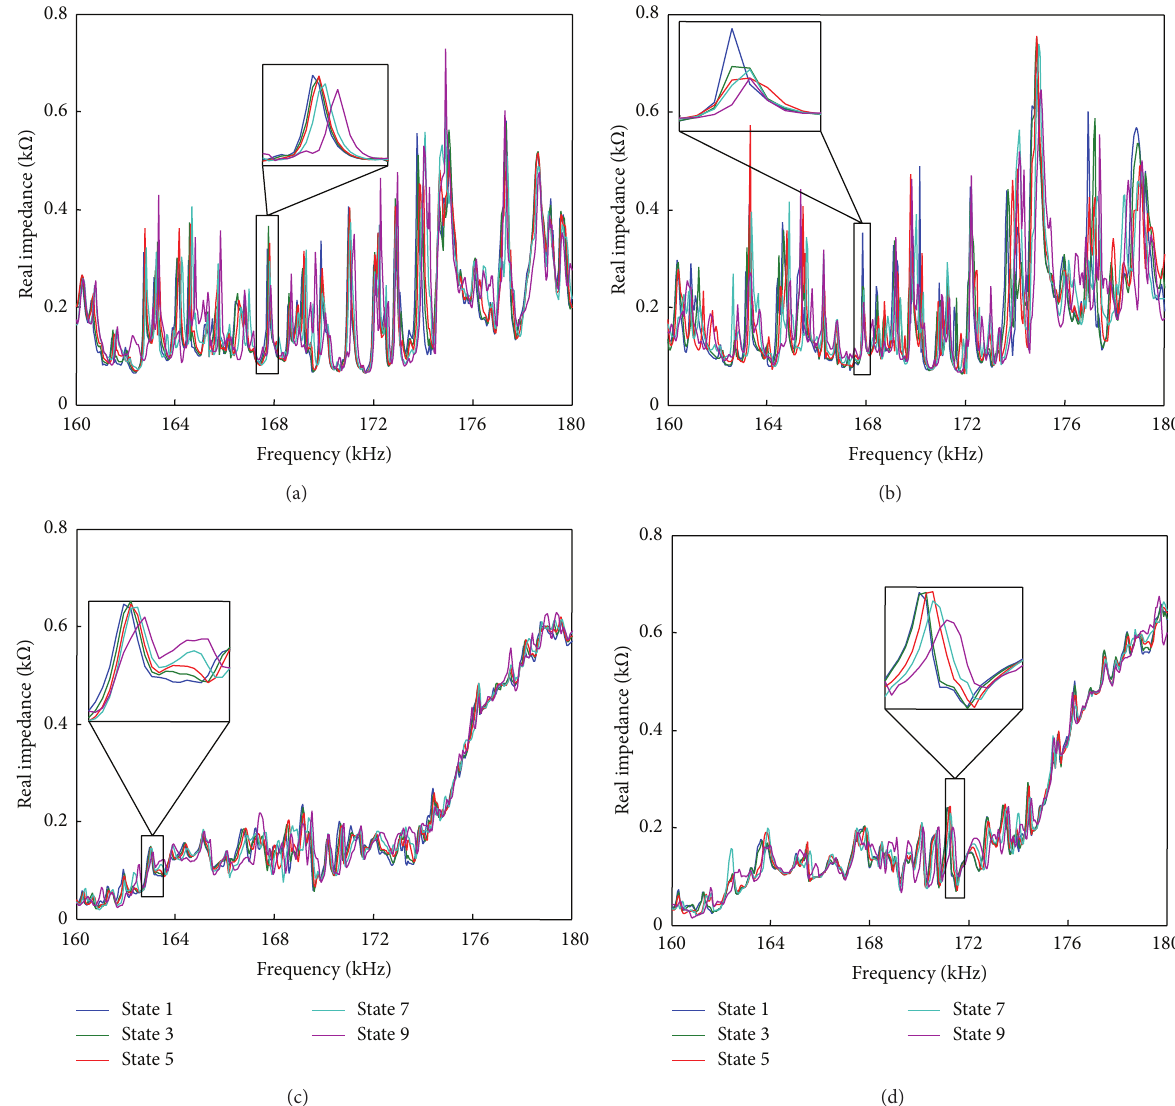
Figure 5: Impedance spectra measured from different rods under some certain states and zoomed parts: (a) rod 1; (b) rod 2; (c) rod 3; (d) rod